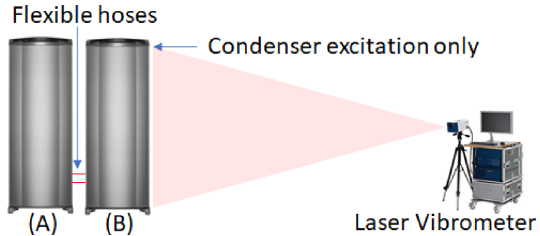
Figure 3. Representation of the cabinet side vibration mapping test.